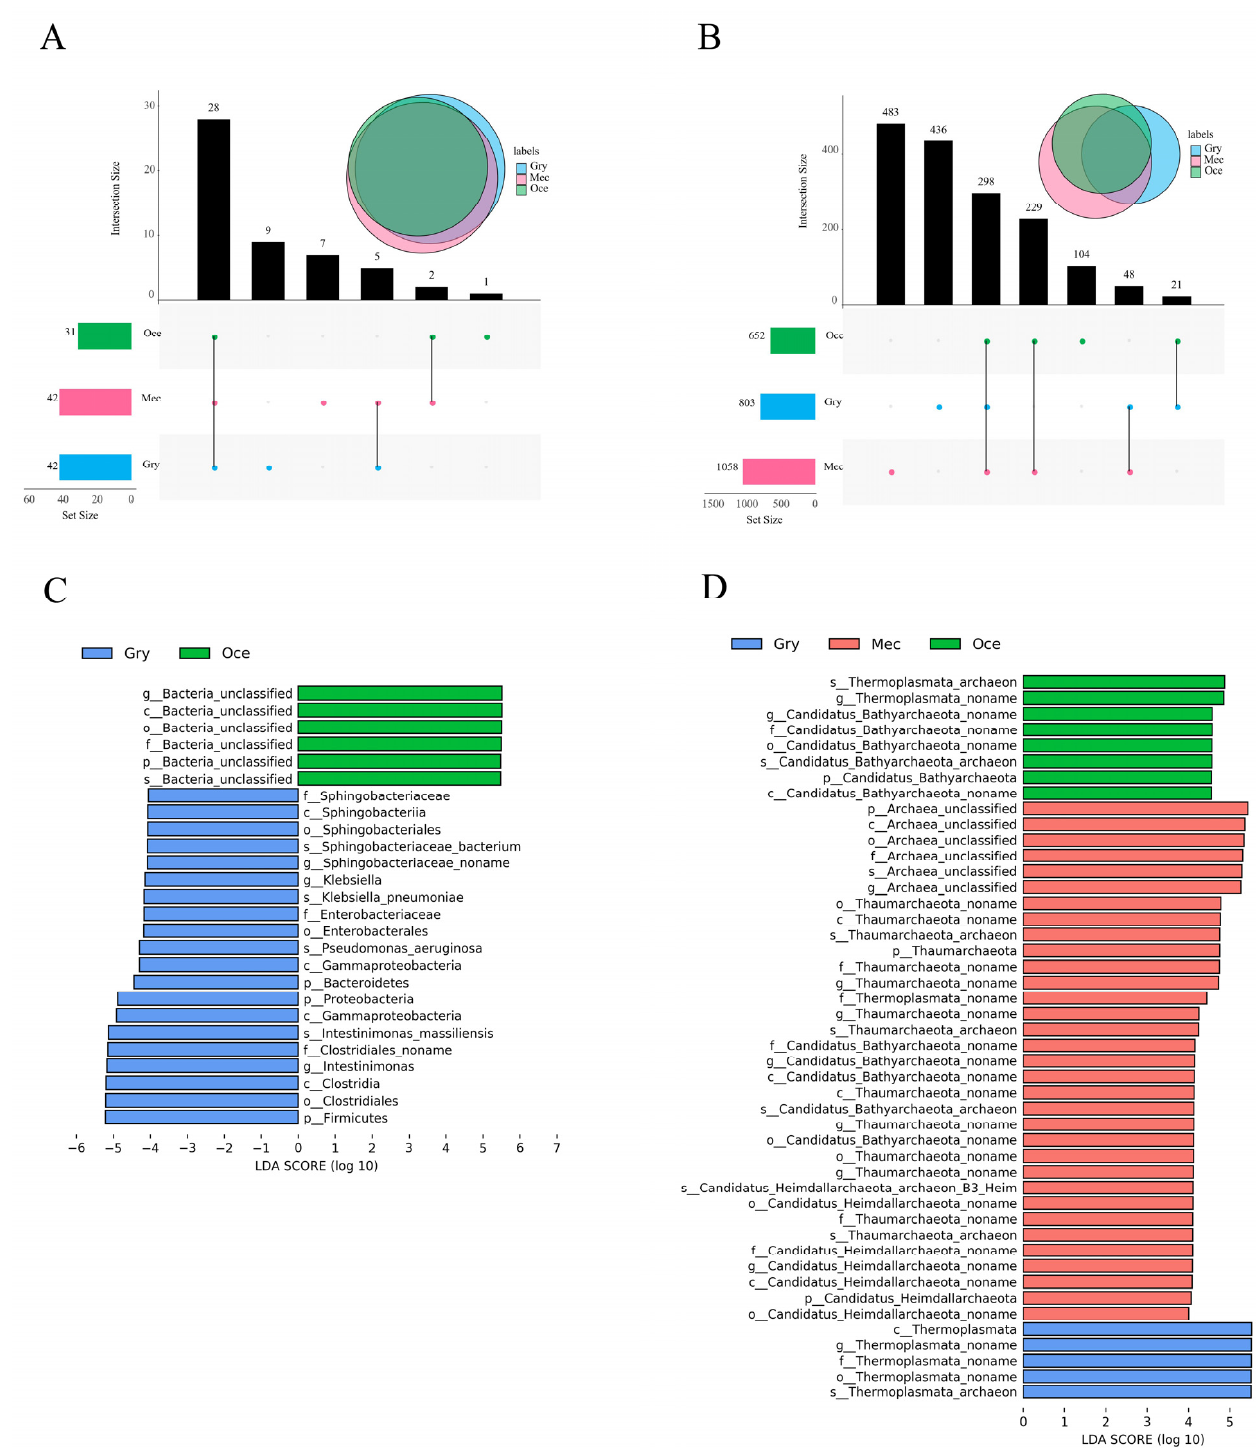
Figure 3. Characteristics of gut microbiota composition. UpSet analysis of the shared and unique microorganisms at the ( A ) phylum and ( B ) species levels between species. Distribution diagram of the LEfSe analysis based on the LDA score of ( C ) bacteria and ( D ) archaea to screen the biomarkers. To further explore the differences in the gut microbiota, LEfSe analysis (LDA score > 4, p < 0.05) was used to find the biomarkers in bacteria (Figure 3C), eukaryotes (Figure S2A), viruses (Figure S2B), and archaea (Figure 3D), with significant abundance differ-